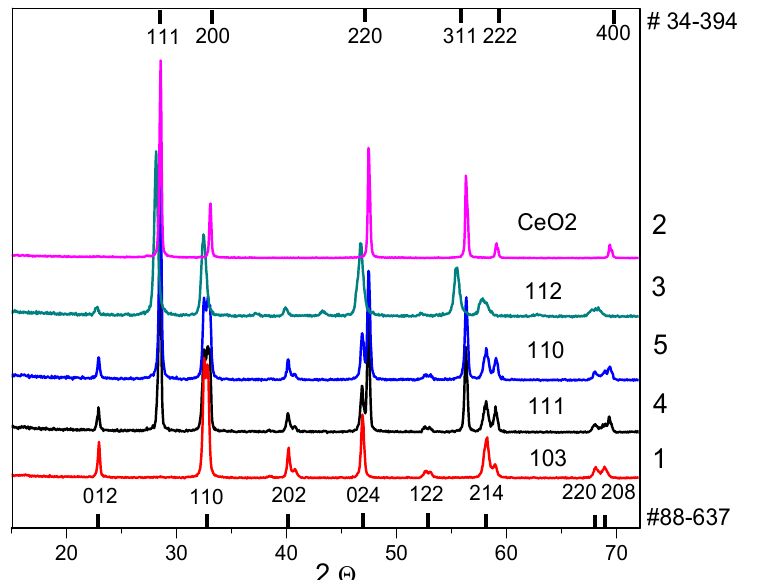
Figure 1. XRD patterns for LaFe 0.4 Ni 0.6 O 3 /CeO 2 samples. Curve numbers (1–5) correspond to the sample numbers (Table 1). Table 2. Cell parameters and X-ray crystallite sizes for perovskite and fluorite phases in samples